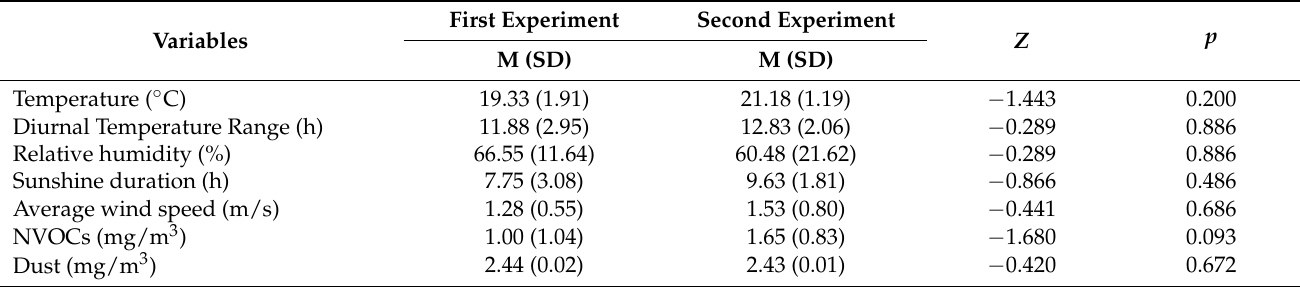
Table 3. Environmental and meteorological variables in the first and the second experiment.